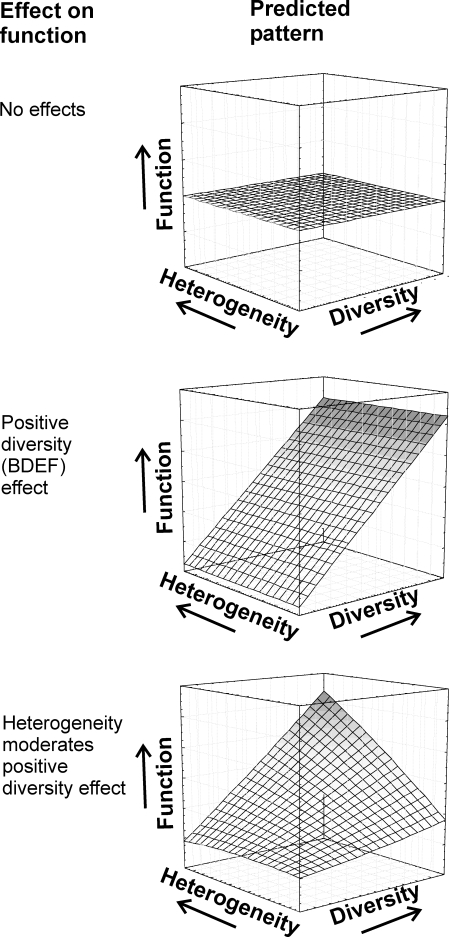
Hypothetical Interactions between Biodiversity and Resource Heterogeneity on Rates of an Ecosystem FunctionNo effect (null hypothesis): neither diversity nor heterogeneity affect functioning. Positive diversity effect: basic diversity-function relationship, with no effect of heterogeneity. Heterogeneity-moderated diversity function: the strength (steepness) of the positive effect of diversity on functioning increases with increasing habitat/resource heterogeneity.